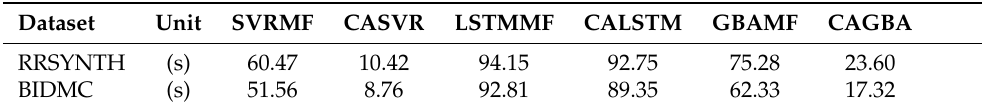
Table 2. Twenty total training and testing times were compared between the conventional and proposed methodology, where the specifications of the computer system are Intel ® Core(TM) i5-9400